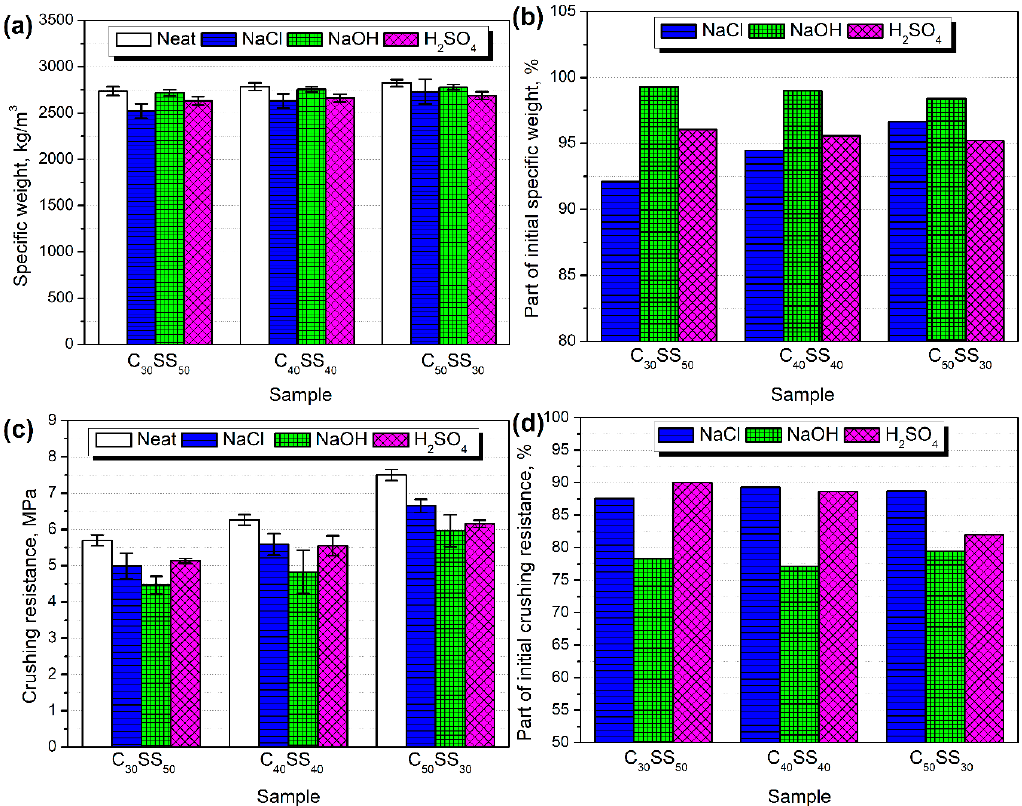
Figure 9. The impact of di ff erent treatments on the ( a , b ) specific weight and ( c , d ) crushing resistance of the analyzed